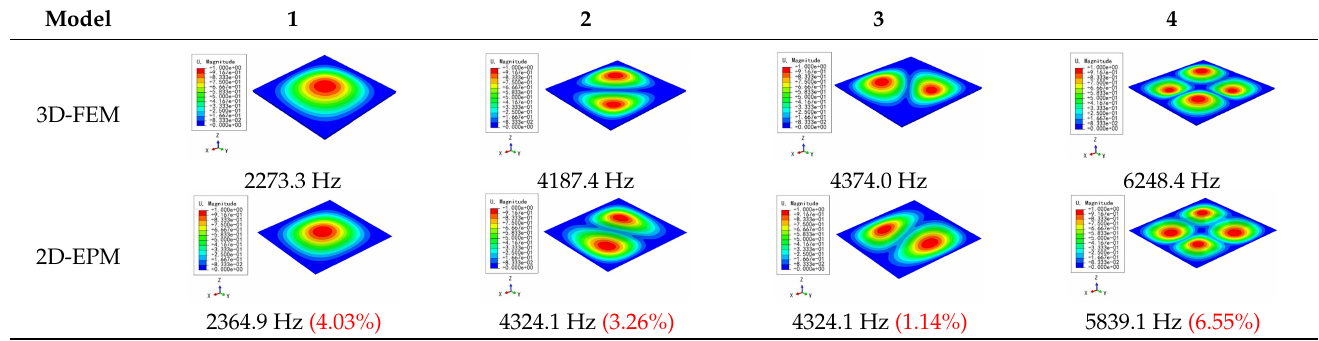
Table 14. Comparison of the first four free vibrations of the orthogrid HSP under CCCC boundary conditions predicted by different models.